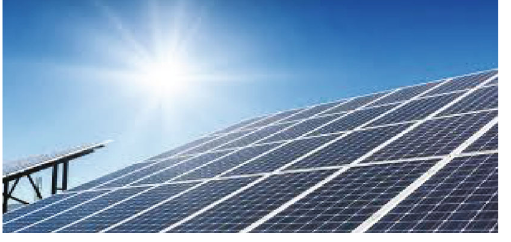
Figure 2: Solar panels.